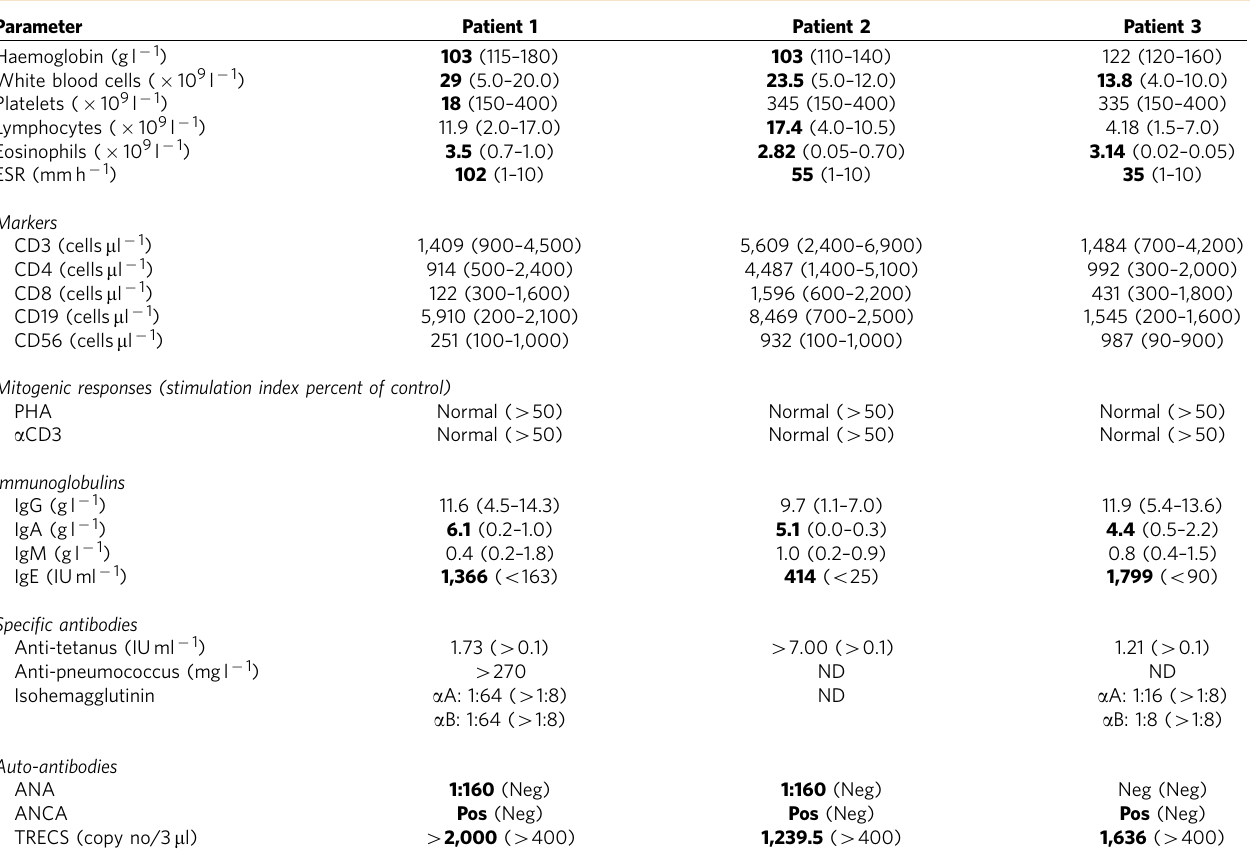
Normal values per age group are shown in brackets. Results outside of normal range in bold.